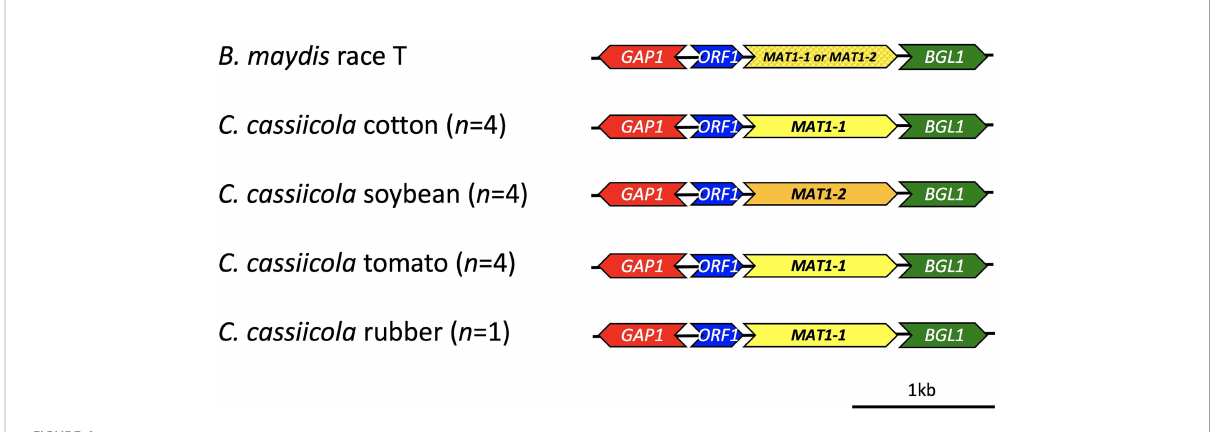
FIGURE 4 Schematic diagram of the mating-type loci ( MAT1 ) in Corynespora cassiicola isolates sampled and sequenced for this study. The mating-type idiomorphs MAT1-1 (AAB82945.1) and MAT1-2 (AAB84004.1), as well as the fl anking genes gap1 (AAB82943.1), unknown orf (AAB82944.1), and bgl1 (AAB82946.1) from Bipolaris maydis were used as references for